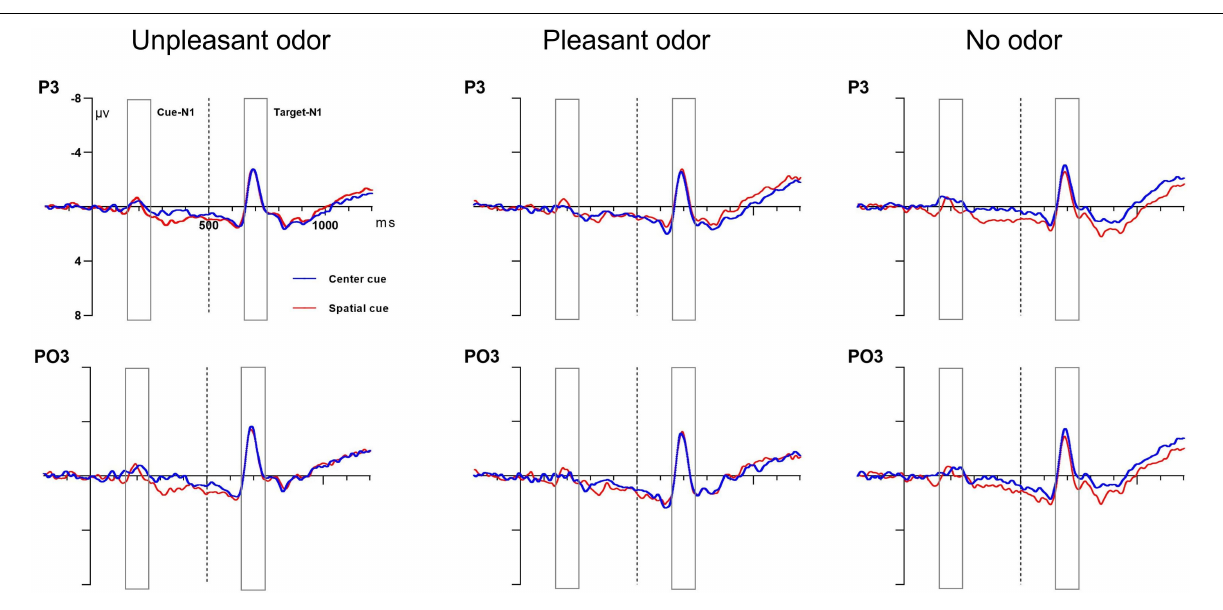
the unpleasant odor at the Fz electrode but not at the FCz electrode. Grand average ERP waveforms at electrodes Fz and FCz in response to target condition are presented in Figure 7 . Topographic maps of the voltage differences in the N1 and N2 component amplitudes are presented for each condition in Figures 8 , 9 ,